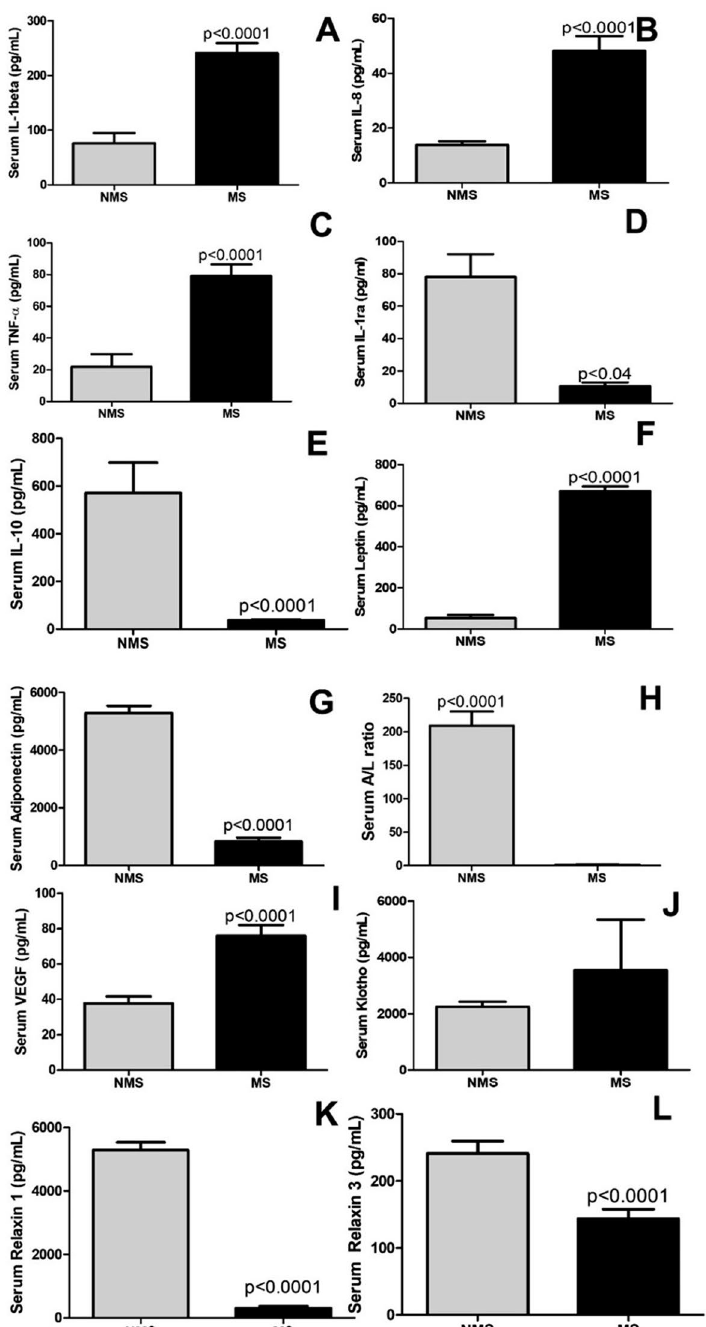
Figure 1. Immunological mediators in the serum in older adults with metabolic syndrome (MS) and without MS. Figure 1A (IL1-beta), Figure 1B (IL-08), Figure 1C (TNF-alfa), Figure 1D (IL1ra), Figure 1E (IL-10), Figure 1F (Leptin), Figure 1G (Adiponectin), Figure 1H (Adiponectin/ Leptin ratio), Figure 1I (VEGF), Figure 1J (Klotho), Figure 1K (Relaxin 1), Figure 1L (Relaxin